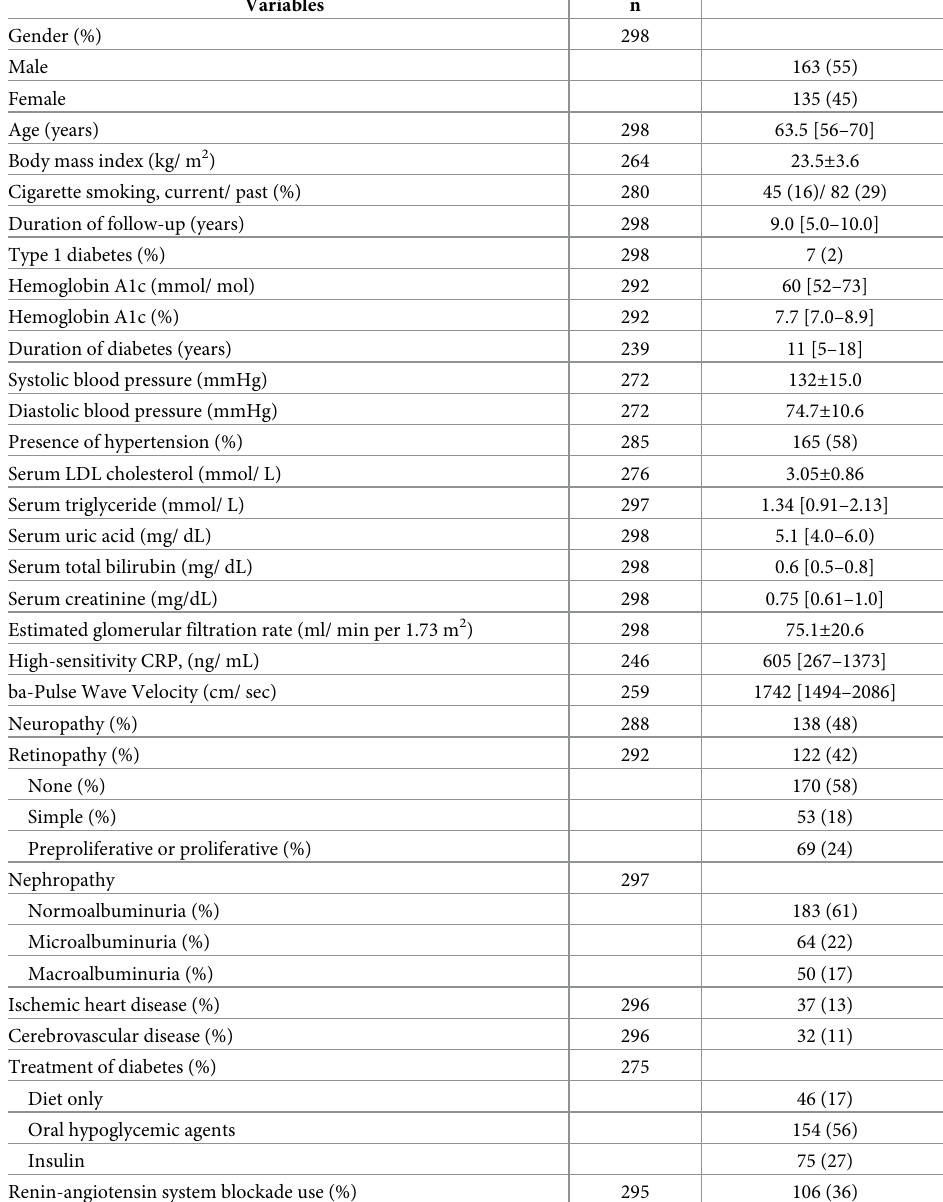
Table 1. Characteristics of the study subjects at